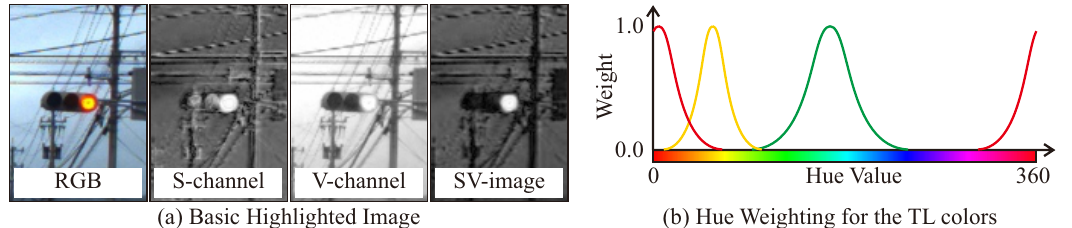
Figure 6. Highlighted image